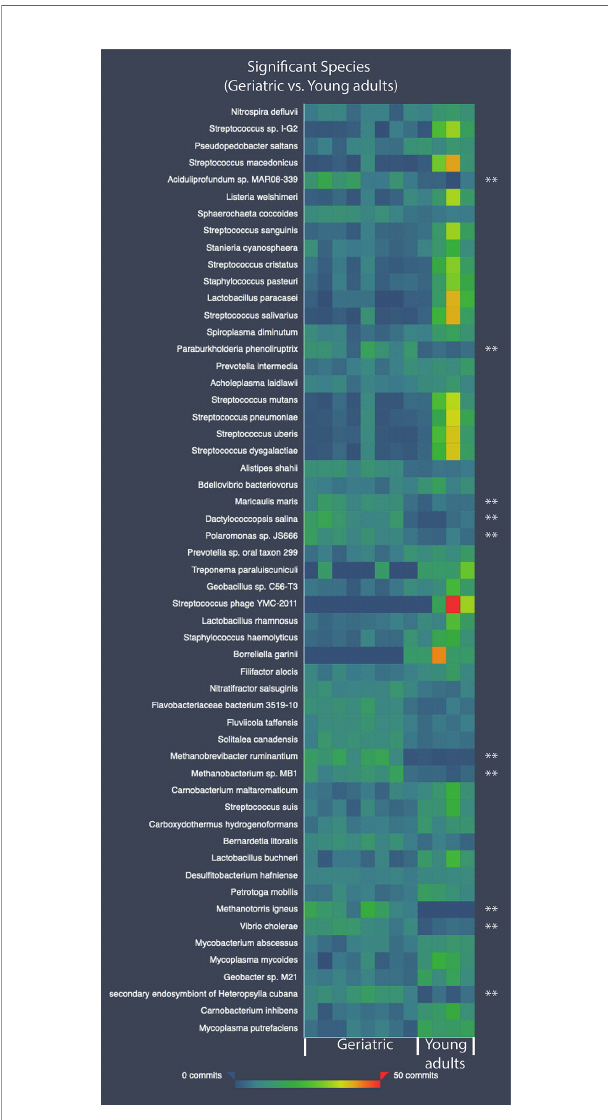
FIGURE 4 | Heatmap showing the relative abundance values for the bacterial species-level differences in the old and young geriatric and young adult animals. All species have signi fi cant differences between groups. Species signi fi cantly higher in old geriatric animals are marked with ‘ ** ’ . The commits in the heatmap are the relative abundance values. Test of signi fi cance was pairwise Mann-Whitney U test and p < 0.05 was considered signi fi